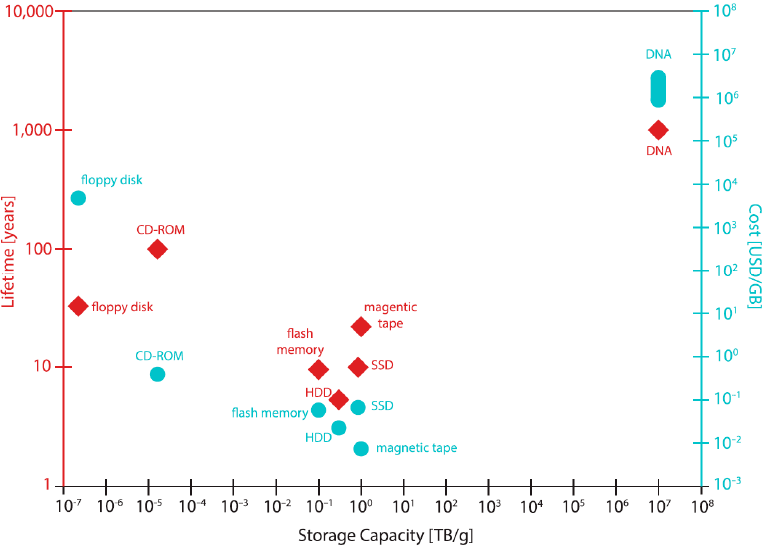
Figure 3. Lifetime, current storage capacity, and costs of various storage systems. Reprinted with permission from [112]. Copyright (2021) Springer Nature.